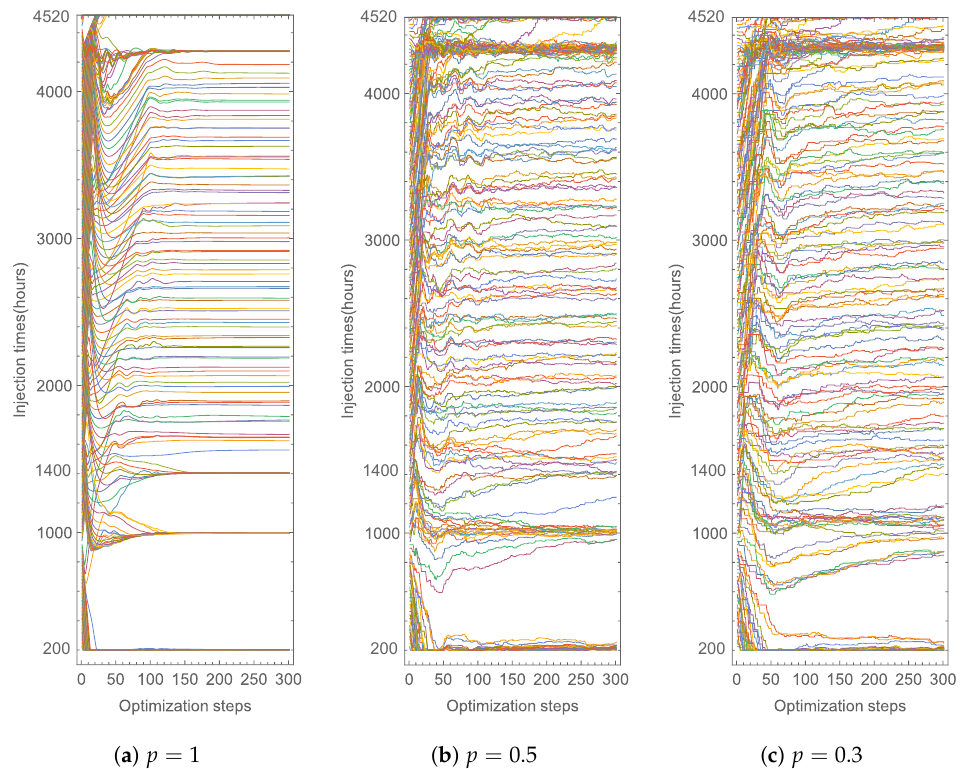
Figure 5. Schedule evolution for p = 1,0.5,0.3. Panel ( a ), the deterministic case, have Algorithm 1 using p = 1. Panel ( b ) stochastic case is done with Algorithm 1 using p = 0.5, so at each optimization step, the algorithm draws 50% of the doses from the schedule to update. Panel ( c ) stochastic case made with Algorithm 1 using p = 0.3. The schedule shows fluctuations for the stochastic